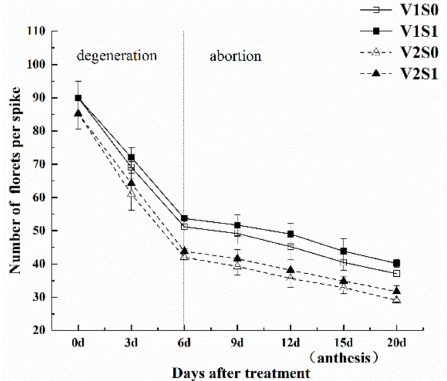
Figure 1. Dynamics of floret development under exogenous 6-BA treatment and the control in wheat. The e ff ects of 6-BA on the number of florets per spike during 2016–2018. Significant at * p =